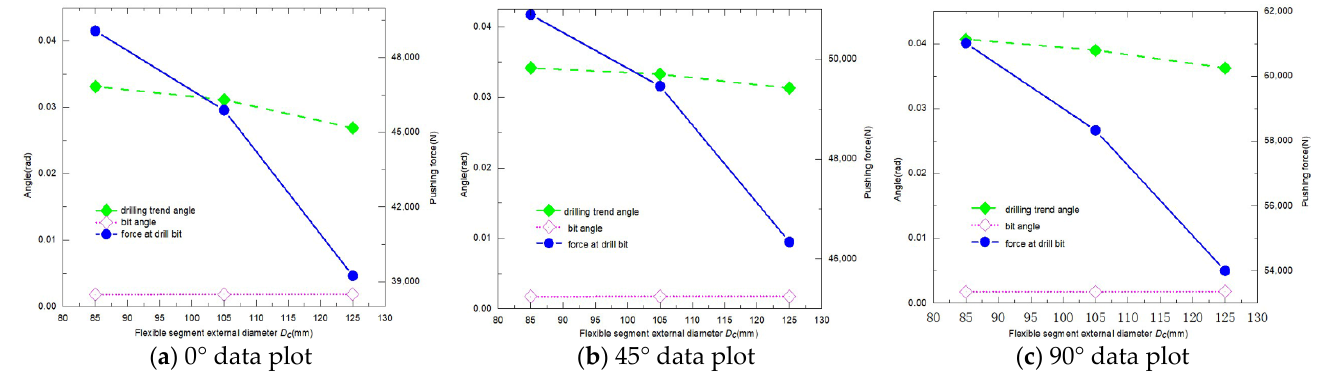
Figure 7. Influence of the flexible segment external diameter (D C ) on trajectory control capacity of the tool.